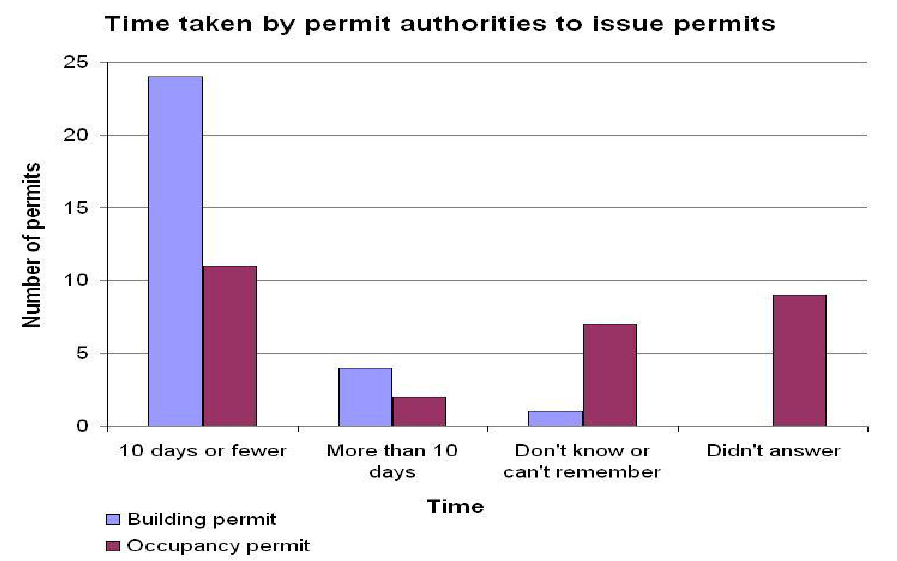
Figure 4 Time taken by permit authorities to issue building and occupancy permits under the Building Act